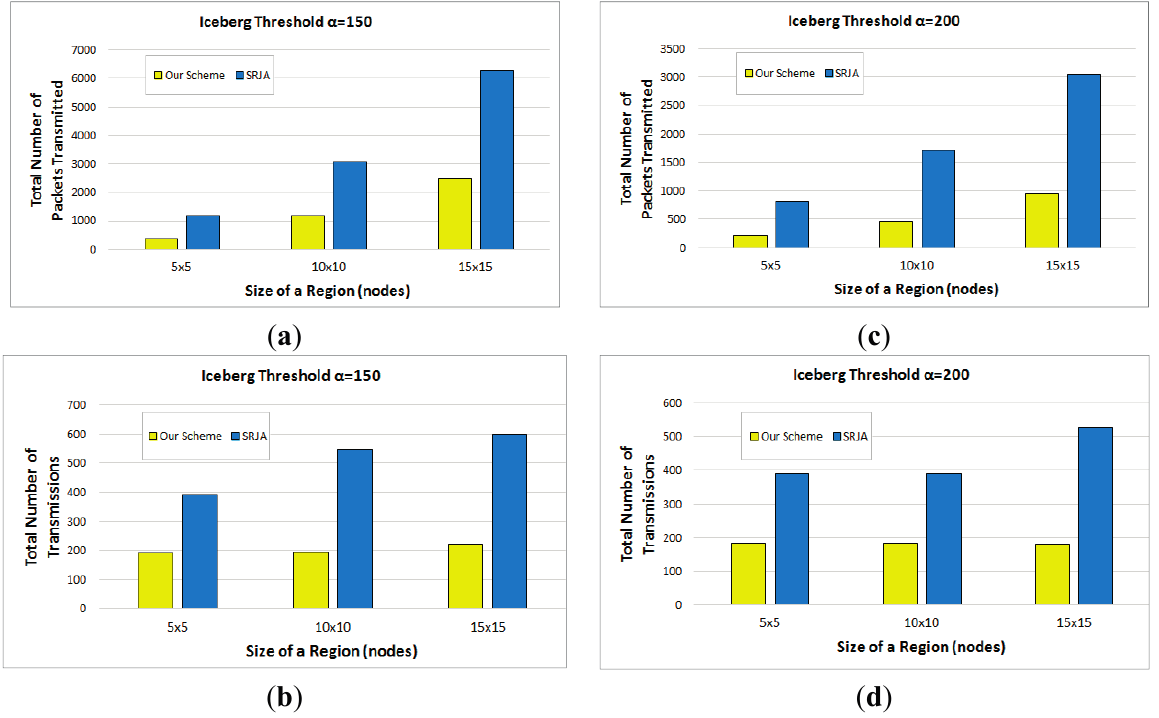
Figure 11. Performance Comparison with respect to Varying Sizes of a Region. ( a ) Total number of packets transmitted ( α = 150 ); ( b ) Total number of transmissions ( α = 150 ); ( c ) Total number of packets transmitted ( α = 200 ); ( d ) Total number of transmissions ( α = 200